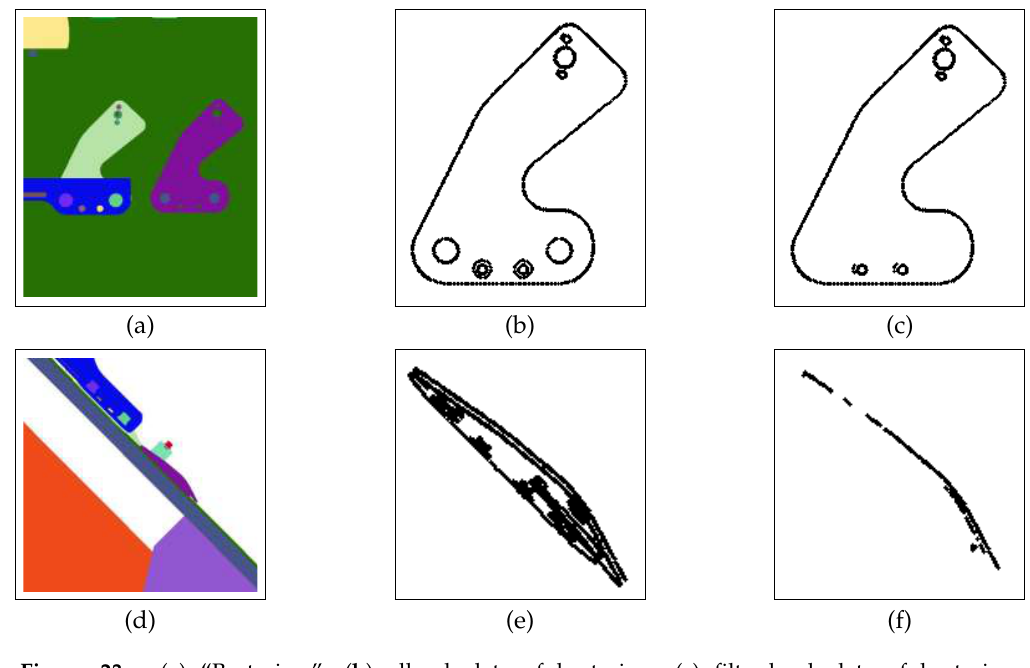
Figure 23. ( a ) “Best-view”, ( b ) all edgelets of best-view, ( c ) filtred edgelets of best-view, ( d ) “worst-view”, ( e ) all edgelets of worst-view, and ( f ) filtered edgelets of